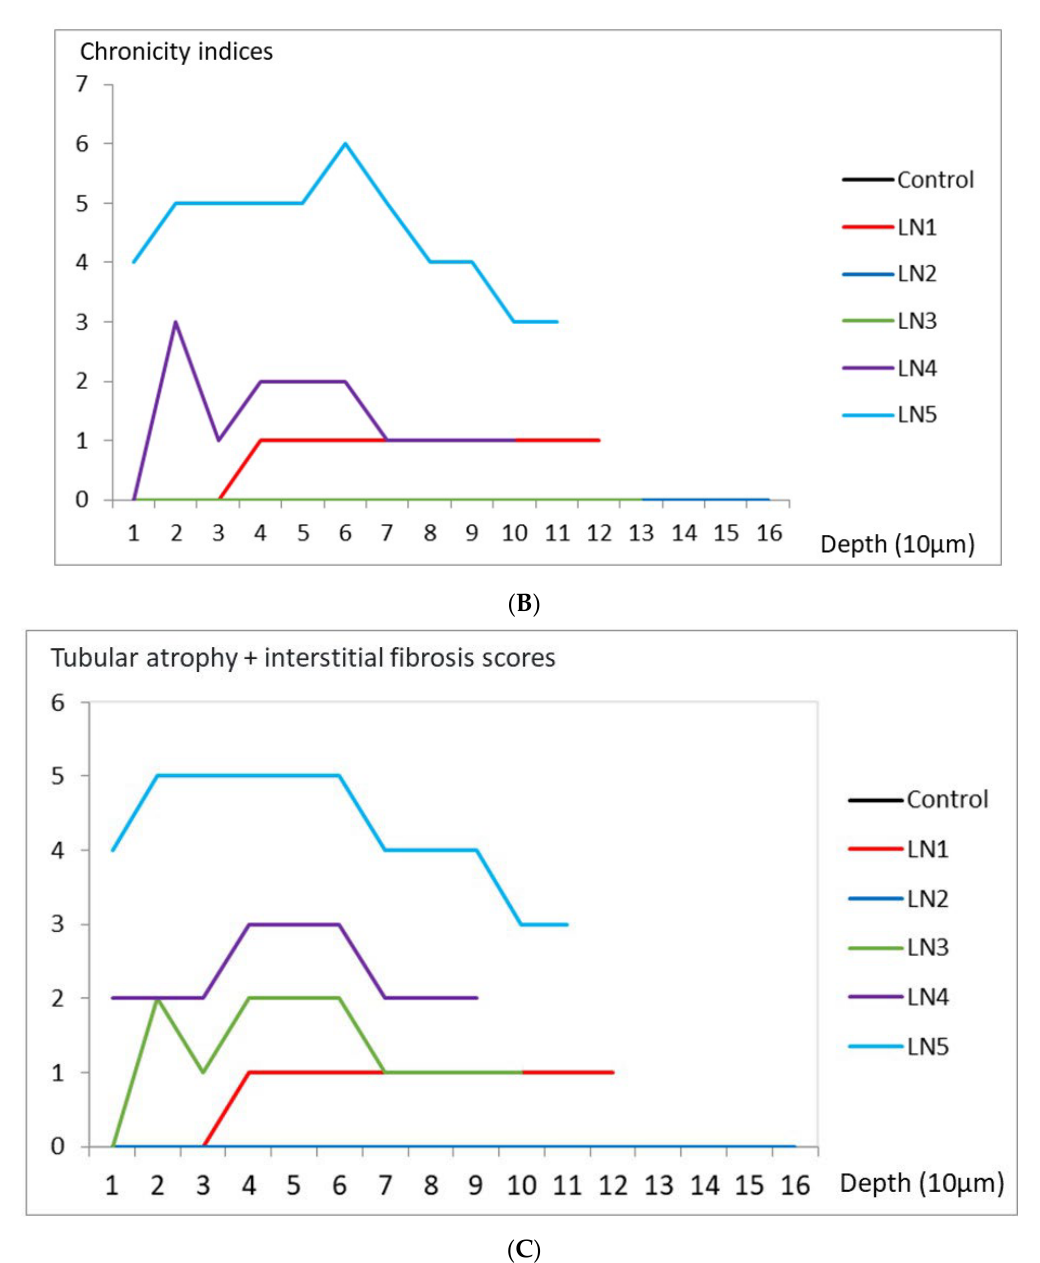
Figure 1. ( A ) II scores from different depths of the renal specimen. ( B ) Chronicity indices from different depths of the renal specimen. ( C ) The sum of tubular atrophy and interstitial fibrosis scores from different depths of the renal specimen.